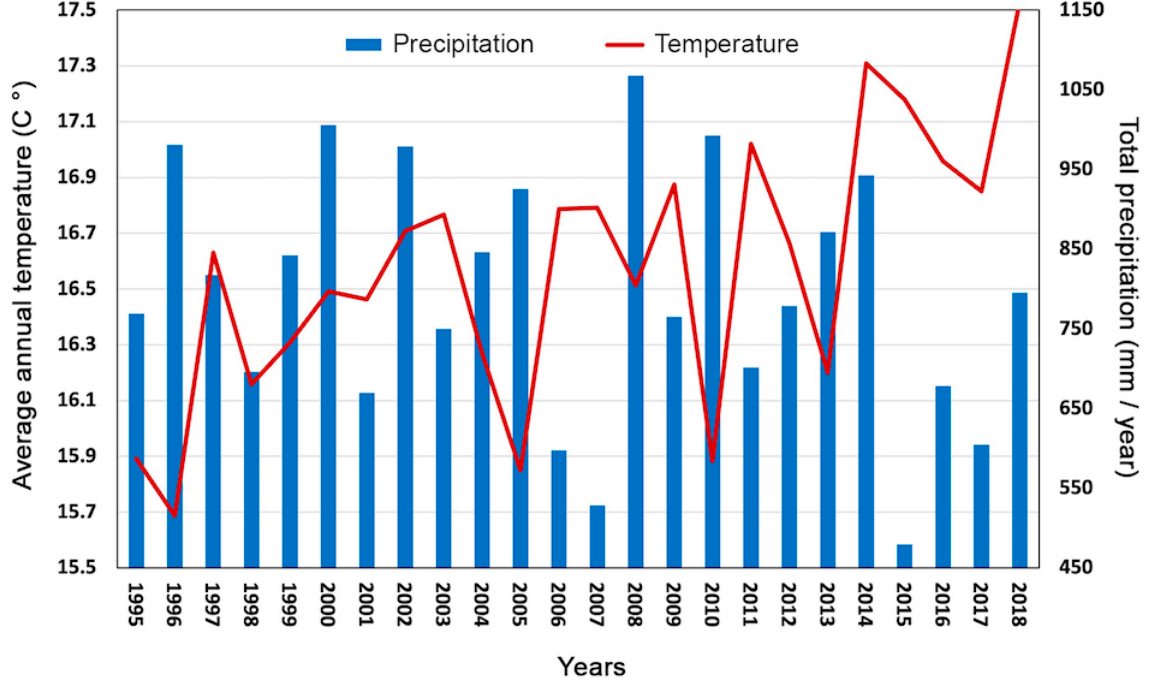
Figure 1. Trend of total annual precipitation in blue (expressed in millimeters/year) and average temperatures in red (expressed in °C) recorded from 1995 to 2018 and coming from the KNMI Climate Explorer database.